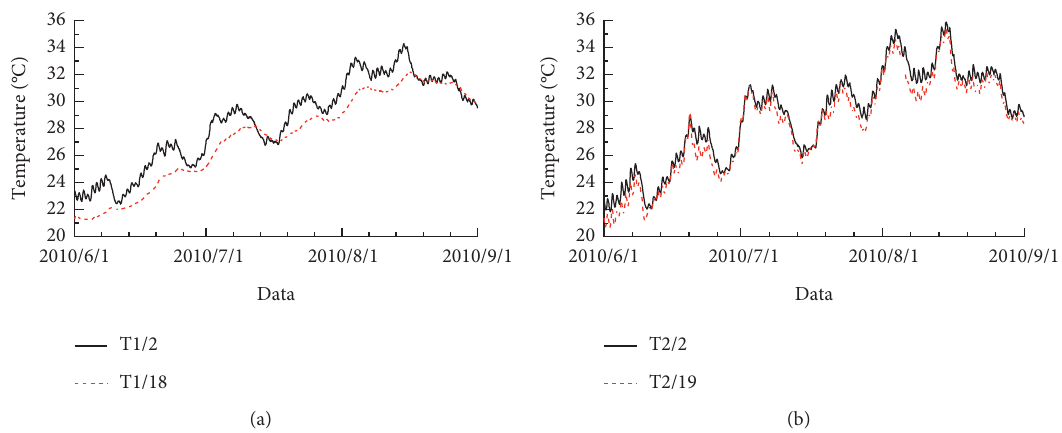
Figure 5: Comparison of the temperature in the web and bottom slab for the period from June 1 to August 31, 2010: (a) T1/2 ∼ T1/18; (b) T2/ 2 ∼ T2/19.